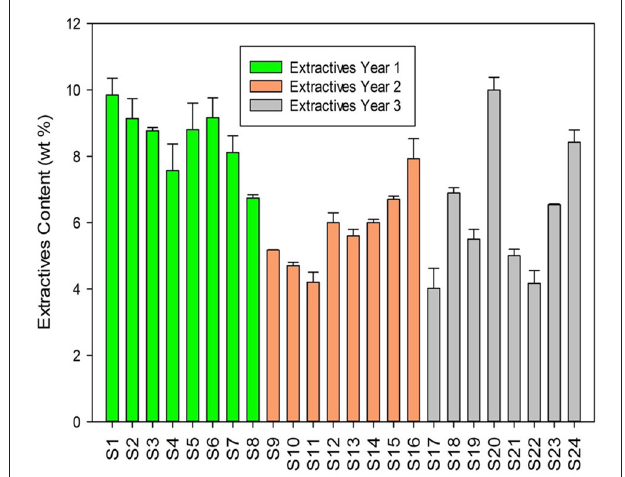
FIGURE 1 | Yield of non-structural components extracted from switchgrass samples harvested for 3 consecutive years.